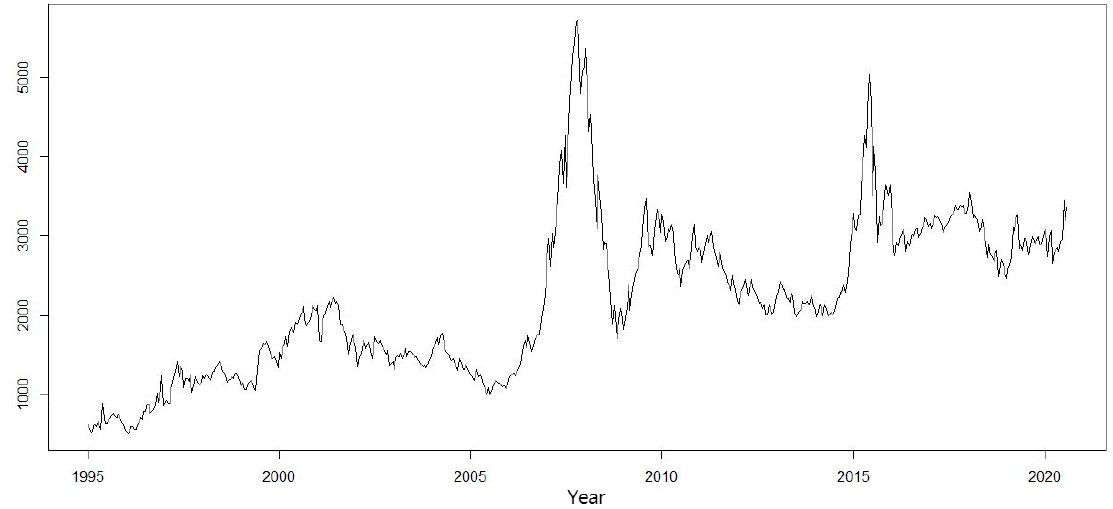
Figure 7. Time series plot of the Shanghai stock index in 1995–2020.